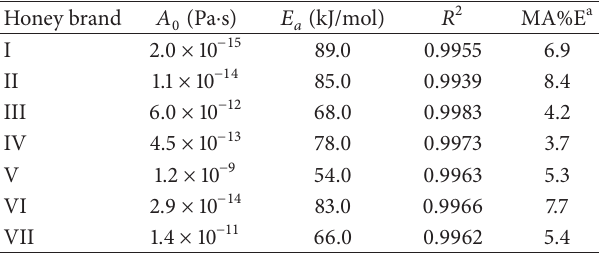
Table 1: Parameters for Arrhenius model for Indian honey. Honey